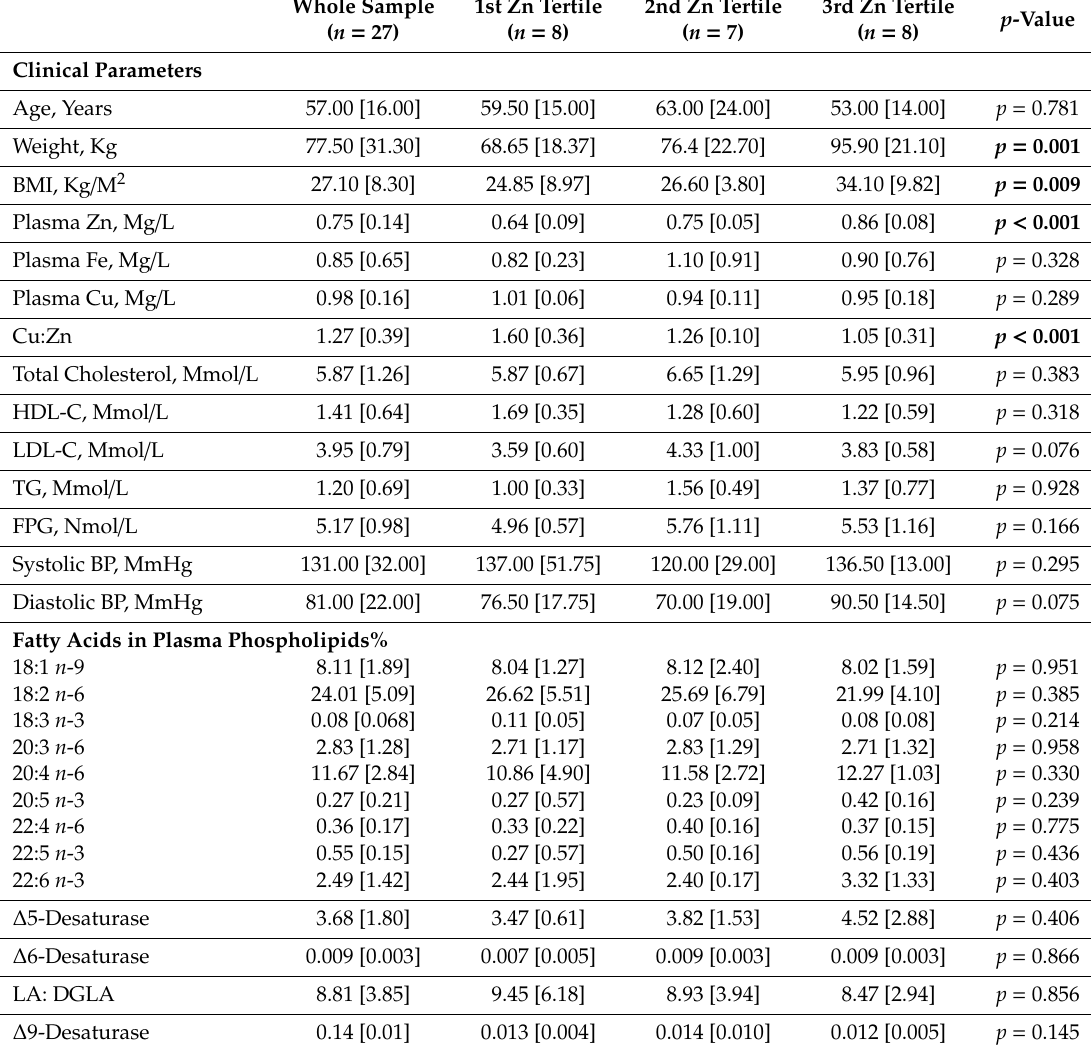
Table 1. Baseline characteristics of study